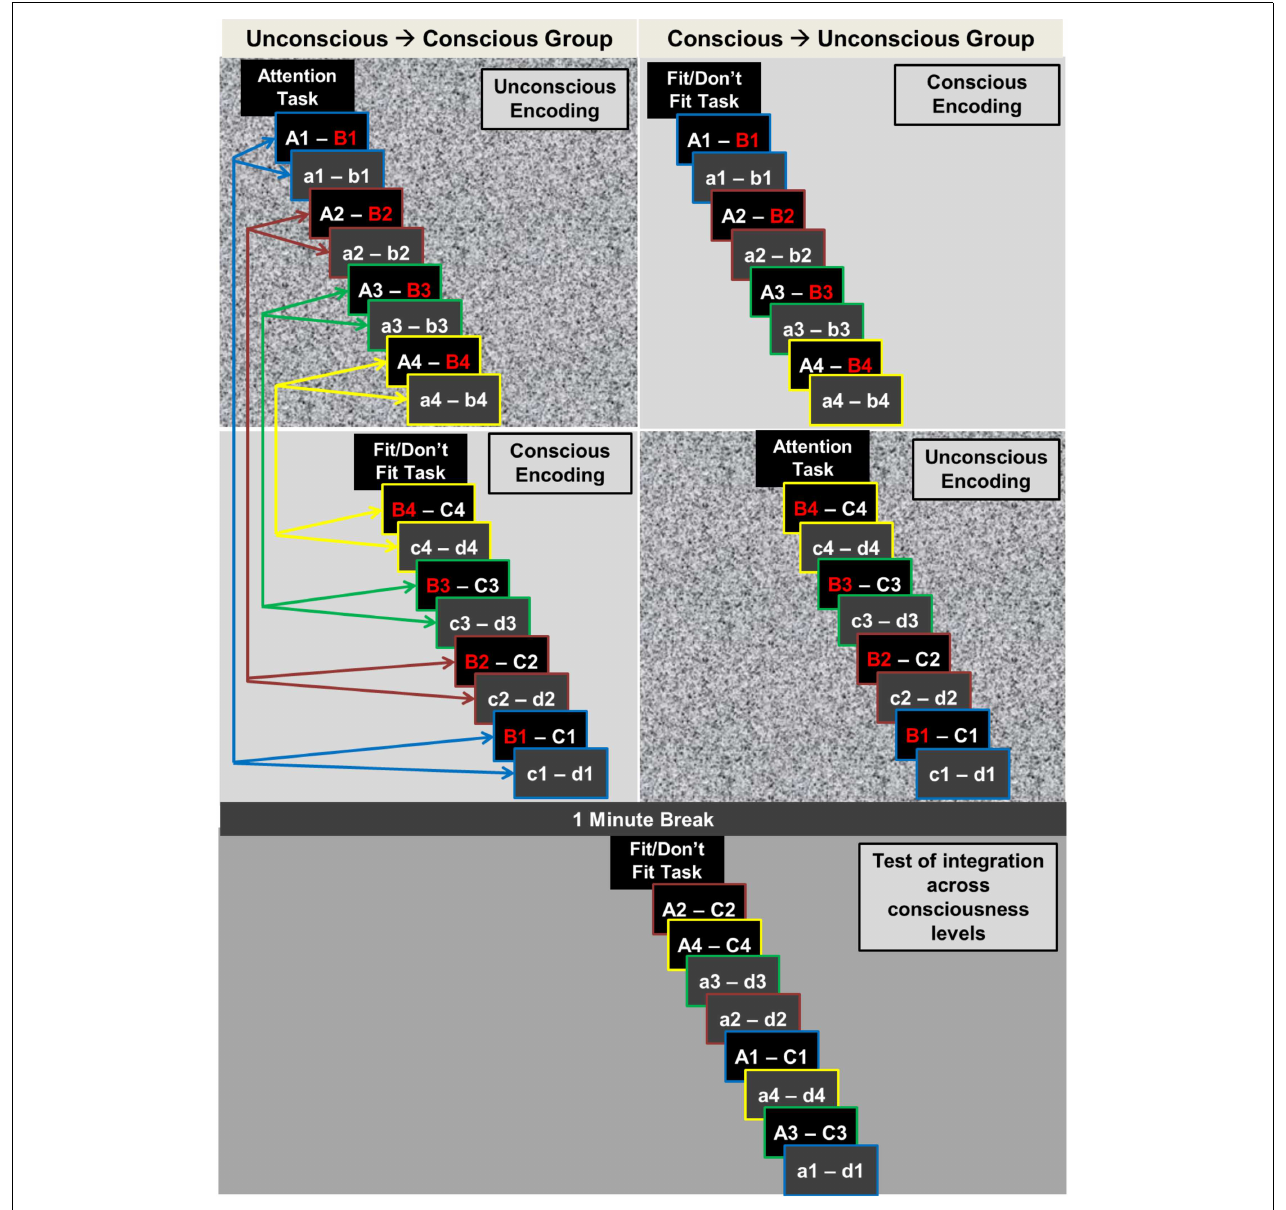
encoding word pairs was varied fourfold with 1, 5, 9, or 13 intervening word pairs.The four distance levels are highlighted with color-coded arrows and color-coded image-frames.The same distances applied to the procedure in the conscious → unconscious group (arrows are omitted in right-hand panel). A break of 1min separated encoding and test.Test trials of the experimental and the control condition were presented in random order and with supraliminal duration for participants in both groups. Both in supraliminal encoding and supraliminal test trials, participants decided whether the two words of a pair fit together semantically or not. During subliminal trials, participants performed an attention task.